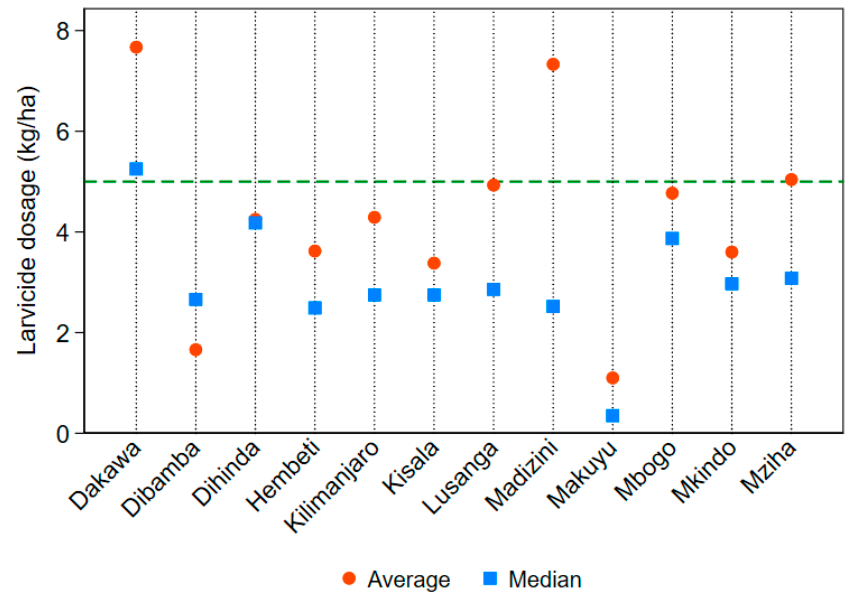
Figure 5. Average and median larvicide application rates (in kilograms per hectare) by village. The green dashed line depicts the standard of 5 kg/ha.